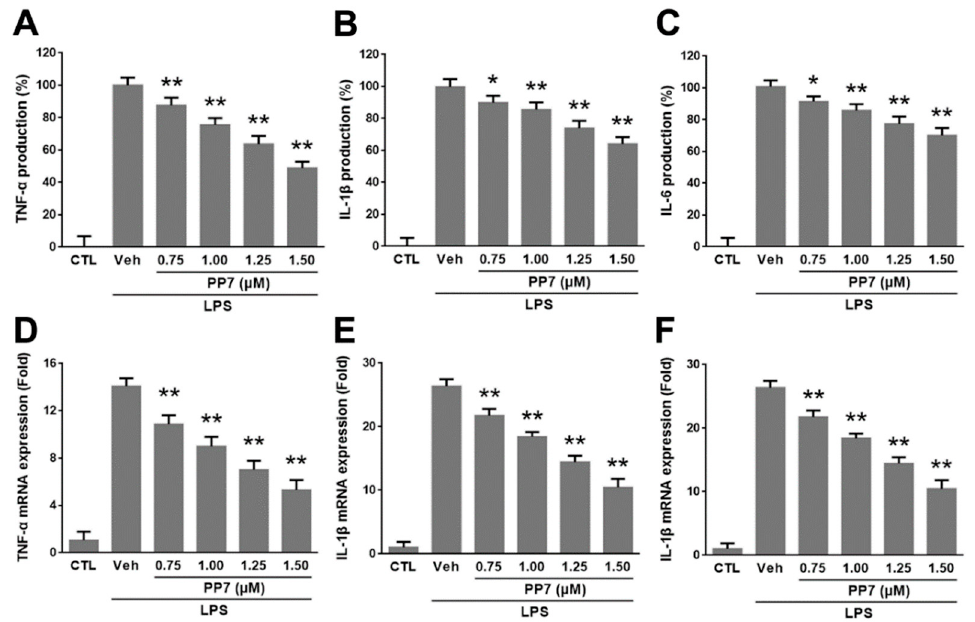
Figure 2. Effect of PP7 on the LPS-induced pro-inflammatory cytokines protein and mRNA expression in RAW264.7 cells. RAW264.7 cells were pretreated with different concentrations (0.75, 1.00, 1.25, and 1.50 µ M) of PP7 for 1 h and then incubated with or without 1 µ g/mL LPS for a further 24 h. Supernatants were collected, and the tumor necrosis factor (TNF)- α ( A ), interleukin (IL)-1 β ( B ), and IL-6 ( C ) production in the supernatants were determined by ELISA. The mRNA levels of TNF- α ( D ), IL-1 β ( E ), and IL-6 ( F ) were determined by RT-PCR. Values represent the means ± SD of triplicate experiments. * p < 0.05 and ** p < 0.01 were compared with LPS-alone group.